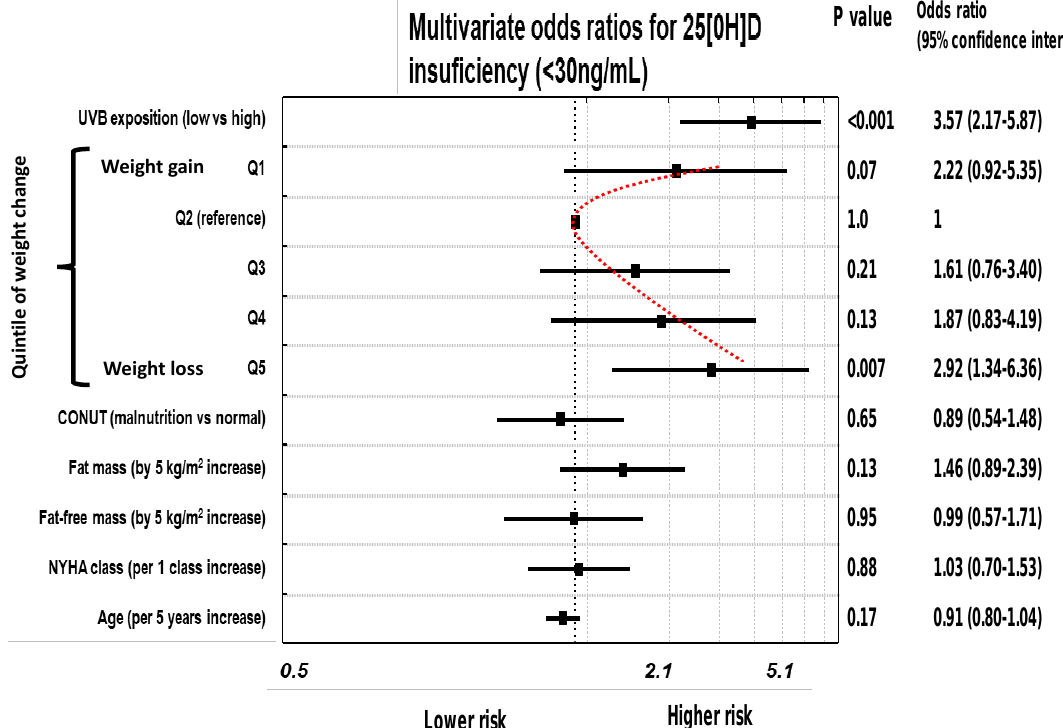
Figure 5. The risk of 25[OH]D insu ffi ciency in patients with di ff erent levels of weight change (WC). Independent predictors in multivariable